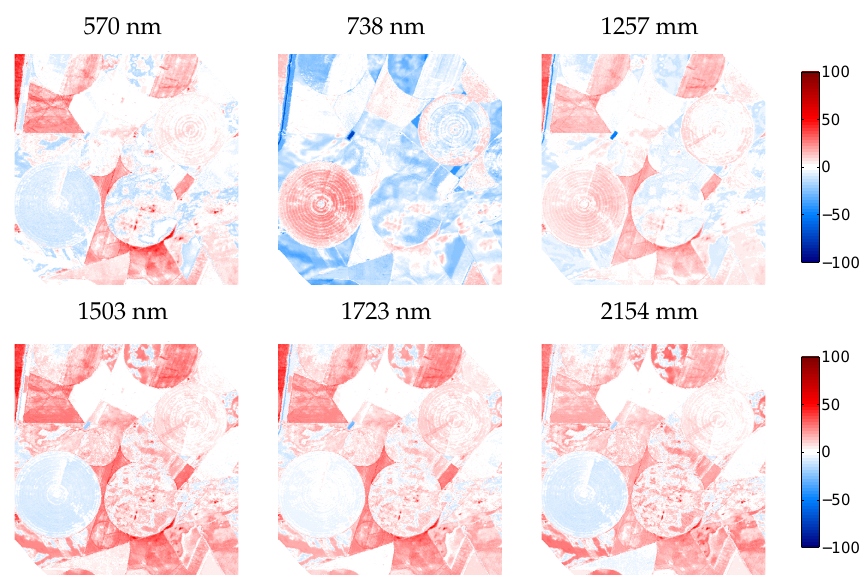
Figure 9. Relative difference maps (%) for arbitrarily chosen wavelengths between KRR-emulated scene and reference HyMap